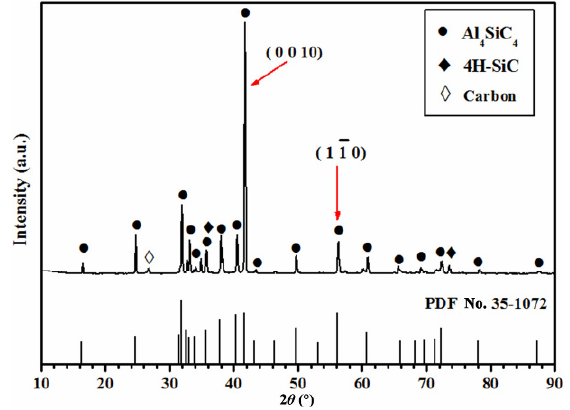
Fig. 1 XRD analysis of the product obtained by carbothermic reduction of Al 2 O 3 /SiO 2 /C powder mixture at 2173 K for 8 h.